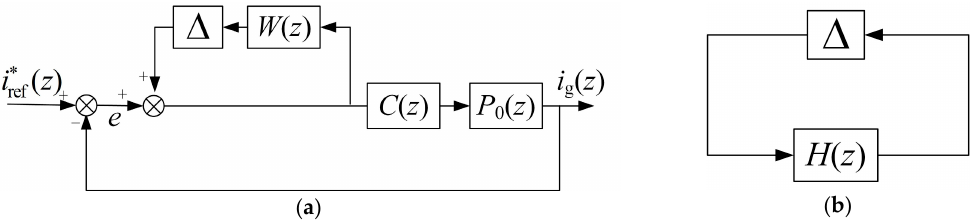
Figure 6. Block diagram of the discrete current control system. ( a ) Complete model; and ( b ) after loop transformation.